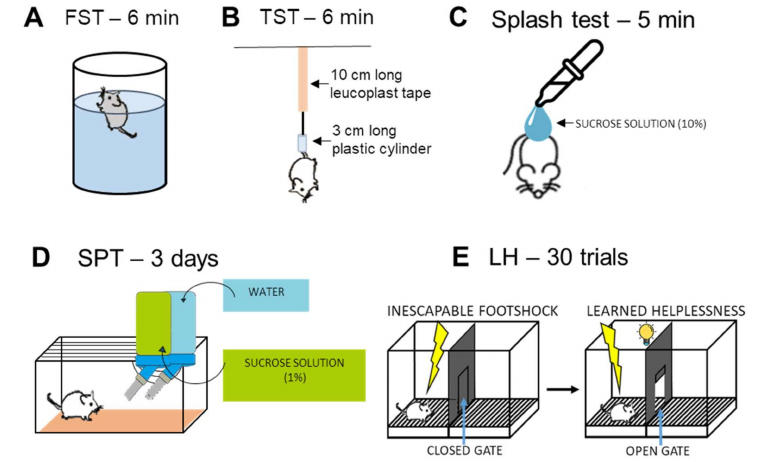
Figure 8. Schematic representation of behavioral tests measuring depressive-like behavior. ( A ): Forced swim test (FST). Mice are forced to swim in a narrow, transparent cylinder filled with tap water from which they cannot escape for 6 min. ( B ): Tail suspension test (TST). Mice were hung for 6 min with a 10 cm long leucoplast tape which was fixed 1 cm from the end of their tails. A 3 cm long plastic cylinder was pulled over their tail, so they were not able to turn and climb back on their tail. ( C ): Splash test. After 10 min habituation mice were splashed with 10% sucrose solution with Pasteur pipettes and then for 5 min the duration of grooming (self-caring) behavior was measured. ( D ): Sucrose preference test (SPT). Mice should discriminate between tap water and 1% sucrose solution. Healthy mice usually prefer sucrose solution over tap water. ( E ): Learned helplessness (LH) test. In both phases, an initial 5 min habituation period preceded the first trial. Test phase consisted of 30 trials of escapable foot-shock (0.15 mA intensity, 10 s maximum duration, 30 s average intertrial interval) with the door open from the light